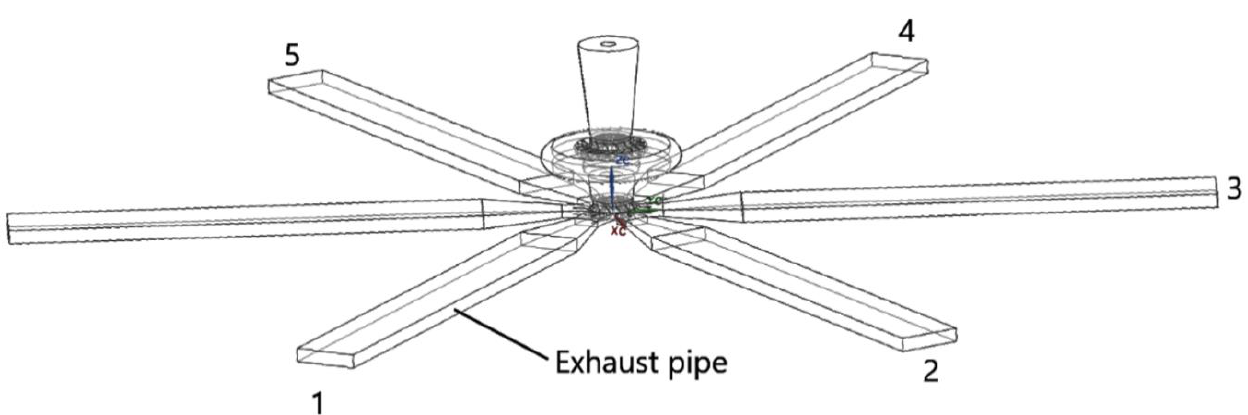
Figure 5. The configuration of the turbine inlet with the six exhaust pipes [27].